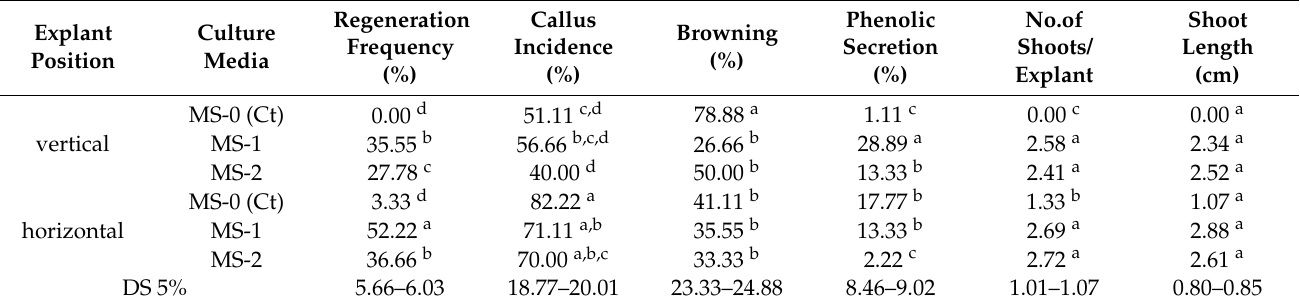
Table 5. Explant position and culture medium influence on axillary shooting in P. quadrangularis .